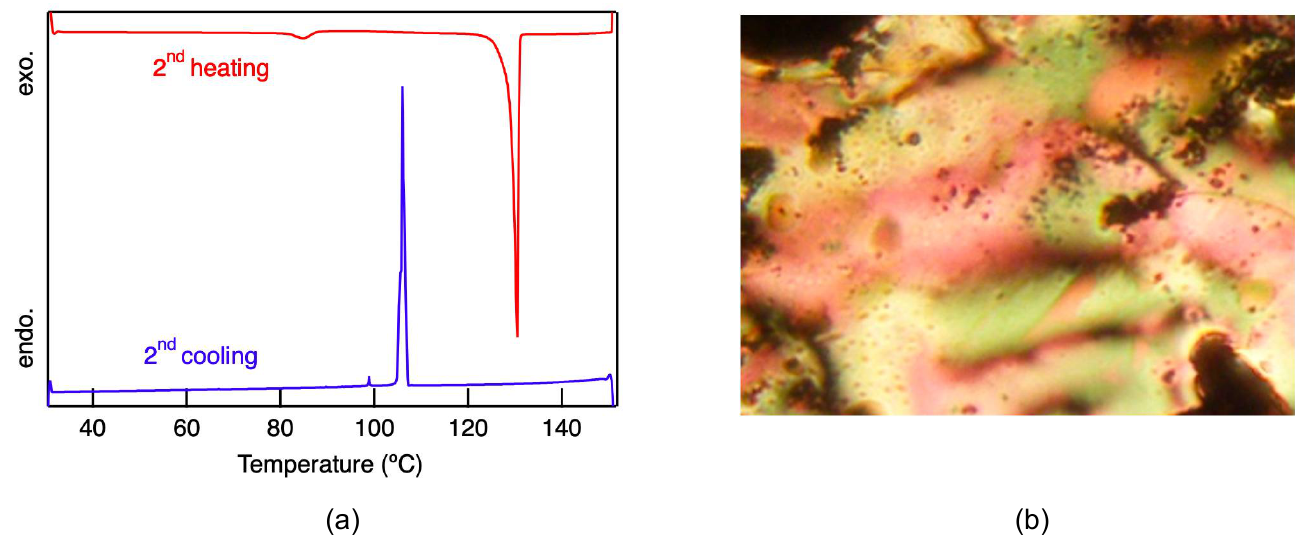
Figure 2. ( a ) A DSC thermogram (second scan) of B3-5 : scanning rate = 2 °C min −1 ; red line, heating; blue line, cooling. ( b ) A POM image of B3-5 , showing the N phase, observed at 140 °C.